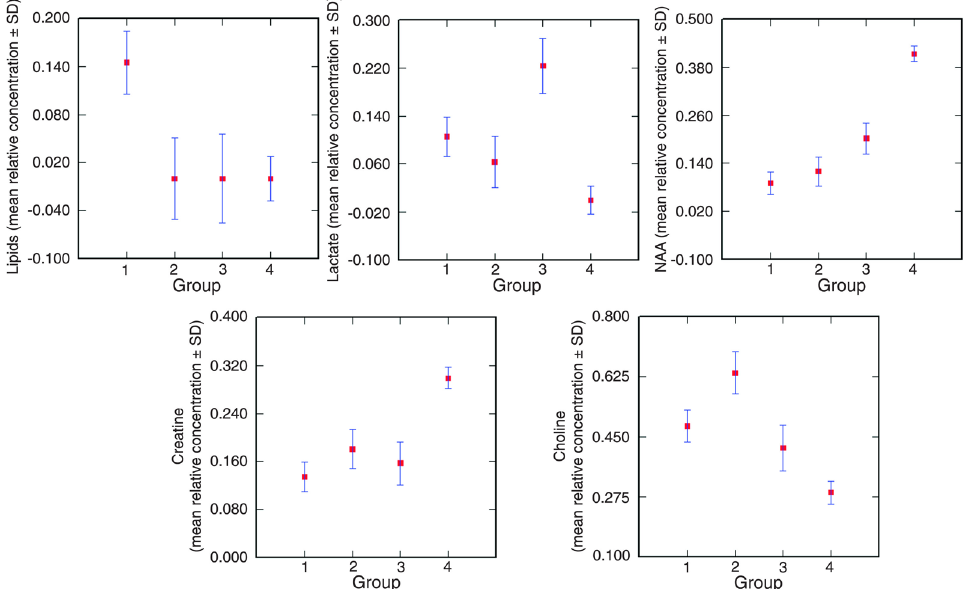
Figure 2. Mean relative concentration ± SD for each tumor group (1 = high-grade neuroglial, 2 = non-neuroglial, and 3 = pilocytic astrocytoma) and for the control group (4). NAA = N-acetyl-aspartate.